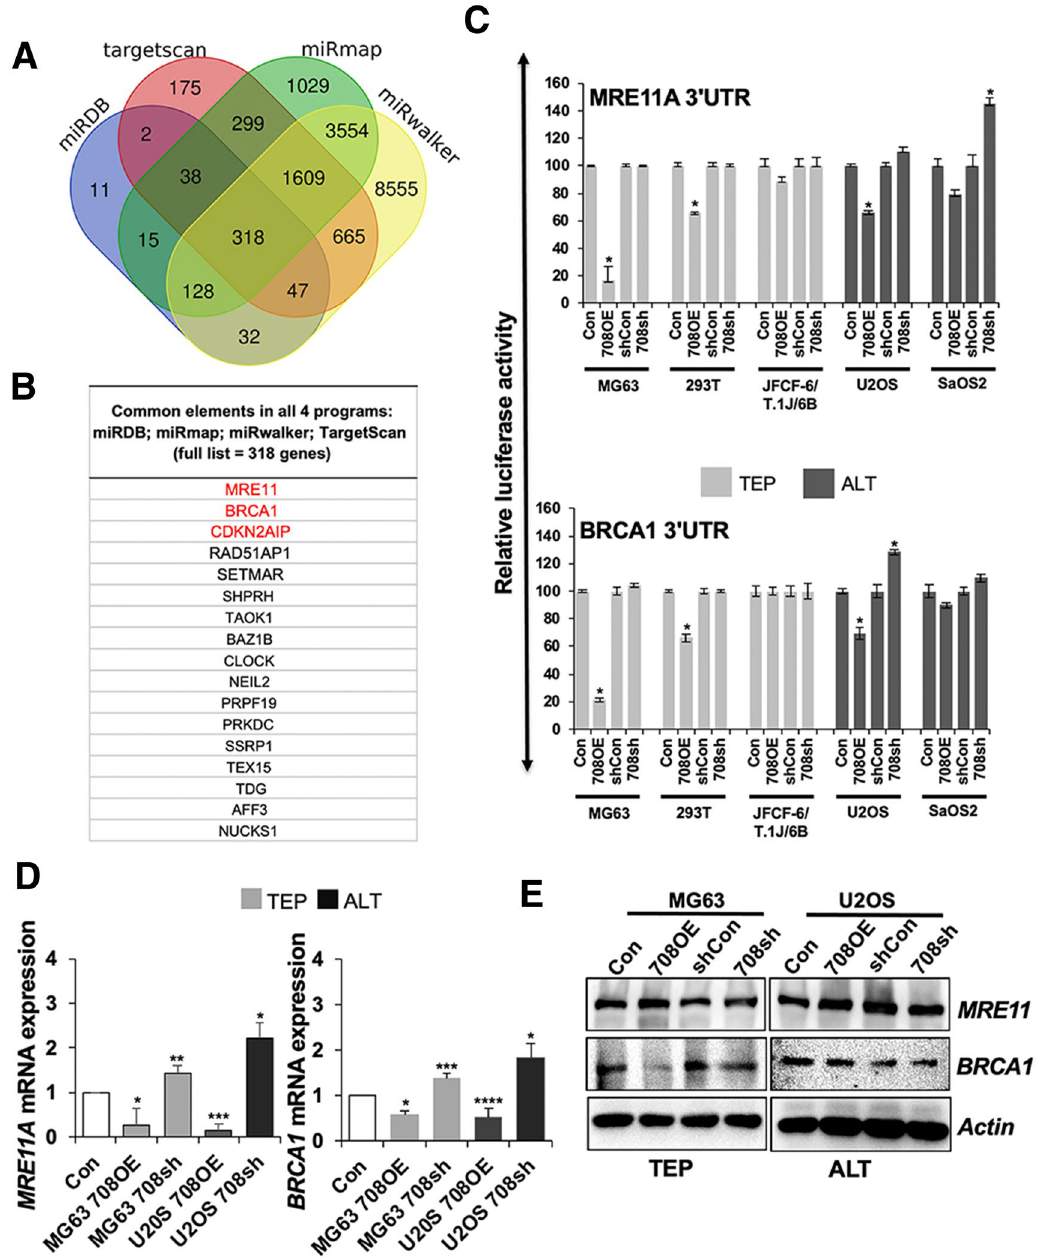
Figure 3. Prediction and validation of miR-708 targets. ( A ) Venn diagram showing the number of genes identified as potential targets of miR-708 as predicted by four algorithms: miRDB, Targetscan, miRmap, miRwalker. 318 genes were found to be common to all four programs. ( B ) MRE11A, BRCA1, and CDKN2AIP (CARF) were found by all four programs to be potential targets of miR-708. ( C ) Luciferase assays showing the repression of the 3 ′ UTR of the candidate genes, MRE11A and BRCA1, by miR-708 in miR-708-overexpressing and -deficient TEP and ALT cell lines, compared to the relevant controls which were assigned a value of 100. Data are shown as mean ± SD, n = 4. ( D ) RT-qPCR validation of MRE11A and BRCA1 transcript levels in miR- 708-overexpressing and -deficient TEP and ALT cell lines, compared to the relevant controls (Con), which were assigned a value of 1. ( E ) Western blotting showed that miR-708 overexpression did not affect MRE11A protein levels, but decreased BRCA1 protein levels. Con: control for miR-708 expression; 708OE: miR-708 expression; shCon: control for miR-708 knock-down; 708sh: miR-708 knock-down using short-hairpin interfering RNA. * p < 0.05; ** p < 0.01; *** p < 0.001; **** p <